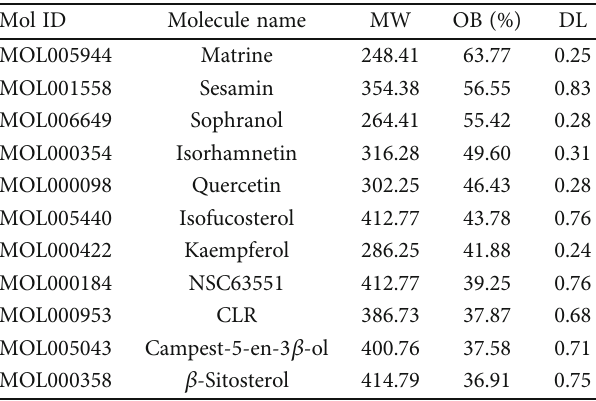
Table 1: The basic information of these 11 active compounds in CS in the TCMSP